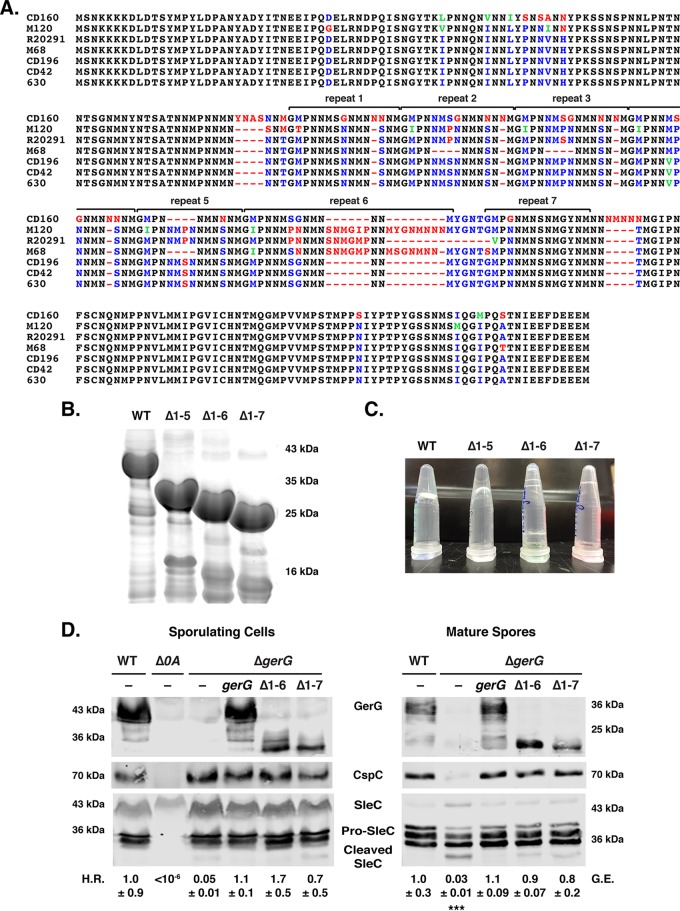
The central repeat region of GerG is required for gel formation but dispensable for spore germination. (A) ClustalW alignment of GerG from selected C. difficile strains. Completely conserved residues are colored black, conserved identical residues are in blue, conserved similar residues are in green, and non-conserved residues are in red. (B) Coomassie blue staining of recombinant, affinity-purified, His-tagged GerG variants. The repeat sequences shown in panel A that were deleted are shown. WT, wild type. (C) Gel formation of GerG variants shown in panel B as determined by inverting the purified protein preparations. (D) Western blot analyses of GerG, CspC, and SleC in sporulating cells and purified spores of the wild type, the Δspo0A mutant, the ΔgerG mutant, and the ΔgerG strain complemented with either wild-type gerG or gerG encoding deletions of repeats 1 to 6 (Δ1–6) or 1 to 7 (Δ1–7). H.R. represents the heat resistance of each strain relative to the wild type; G.E. refers to the germination efficiency of each strain relative to the wild type. The means and standard deviations shown are based on three biological replicates. Statistical significance relative to the wild type was determined using a one-way analysis of variance and Tukey’s test. ***, P < 0.0005. No statistically significant difference was observed between the strains used in the heat resistance assay due to high variance in sporulation levels. No statistically significant difference in germination efficiency was observed between Δ1–6 and Δ1–7 relative to the wild type.